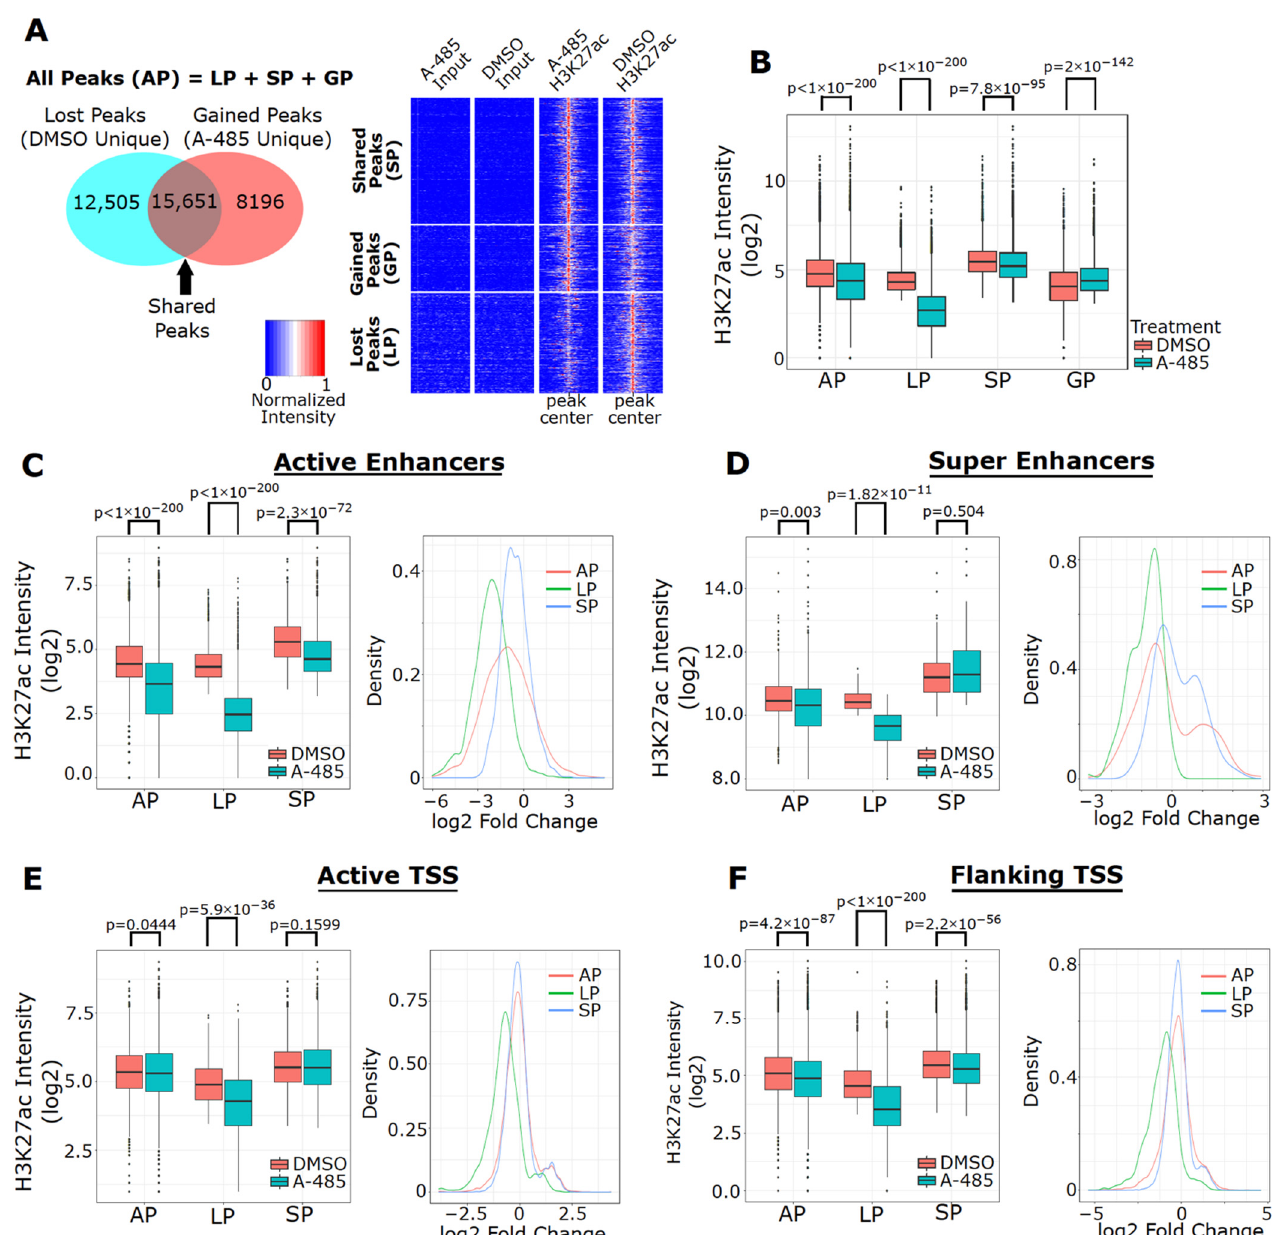
Figure 5. A-485 preferentially suppresses H3K27ac at enhancers. ( A ) Venn diagram of the number of H3K27ac peaks detected in four peak types (All Peak (AP), Lost Peak (LP), Gained Peak (GP) and Shared Peak (SP)) in MCF-7 cells treated with A-485 (3 µM) for 24 h (left). Heatmaps depicting normalized H3K27ac peak intensity (at peak center ± 3 kb) in Lost, Gained and Shared peaks are shown (right). ( B ) Boxplots of H3K27ac peak intensity for DMSO and A-485 in each of the peak types. Boxplots of H3K27ac peak intensity in MCF-7 cells treated with A-485 or DMSO (left) and fold-changes of H3K27ac (right) at active enhancers ( C ), super enhancers ( D ), active TSSs, ( E ) and flanking TSSs, ( F ) in each of the peak types.